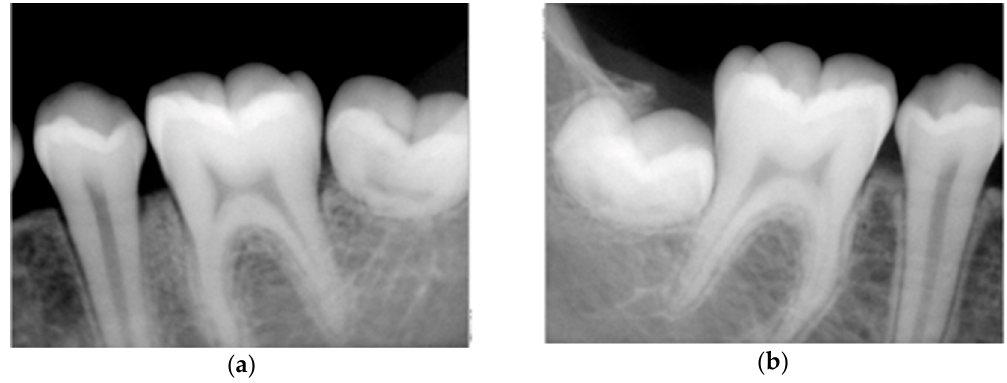
Figure 4. Periapical lower arch x-rays. ( a ) Third quadrant with 3.5, 3.6 and missing roots of 3.7; ( b ) Fourth quadrant with 4.5, 4.6 and missing roots of 4.7.